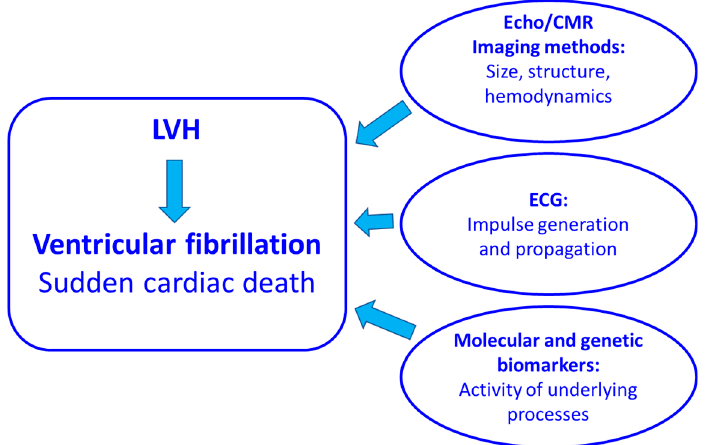
Figure 1. A spectrum of biomarkers providing information on the size of the left ventricle, its structure, hemodynamics, electrical impulse generation and propagation as well as on the activity of the underlying processes is currently available. They describe specific aspects of the complex hypertrophic rebuilding of the left ventricle. CMR: cardiac magnetic resonance, LVH: left ventricular